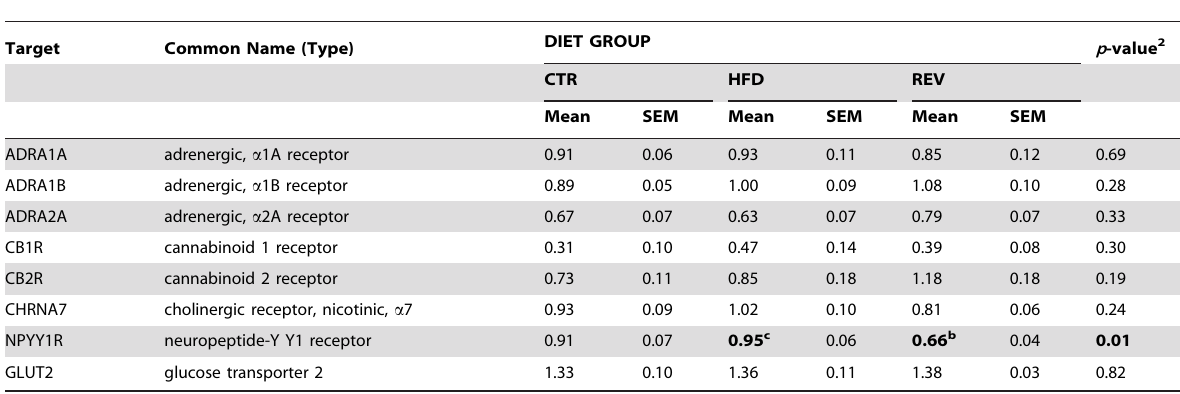
Table 2. Peripheral Nervous System mRNA expression in Fetal Macaque Liver. 1